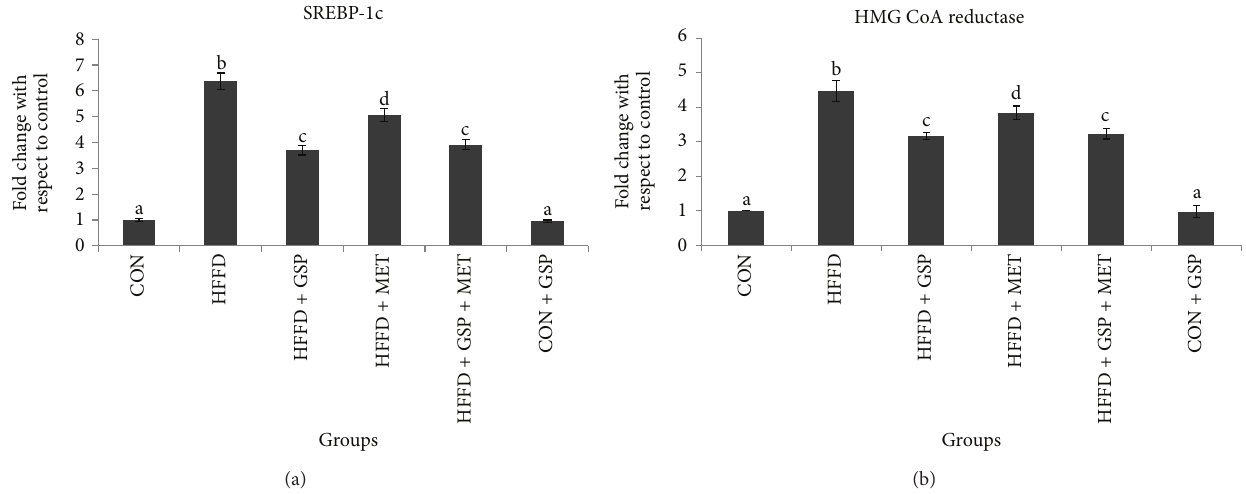
Figure 5: Effect of GSP and MET on mRNA expression of lipogenesis markers in liver of experimental animals. mRNA of SREBP-1c (a) and mRNA of HMG CoA reductase (b). Experiments were performed in triplicates, and the data expressed are means ± S.D. of 3 rats from each group. The obtained Ct values of the test genes were normalized with GAPDH and expressed in bars as fold change. Statistical significance between the groups, denoted by different alphabets, was determined by one-way ANOVA of significance set at 𝑃 < 0.05 .